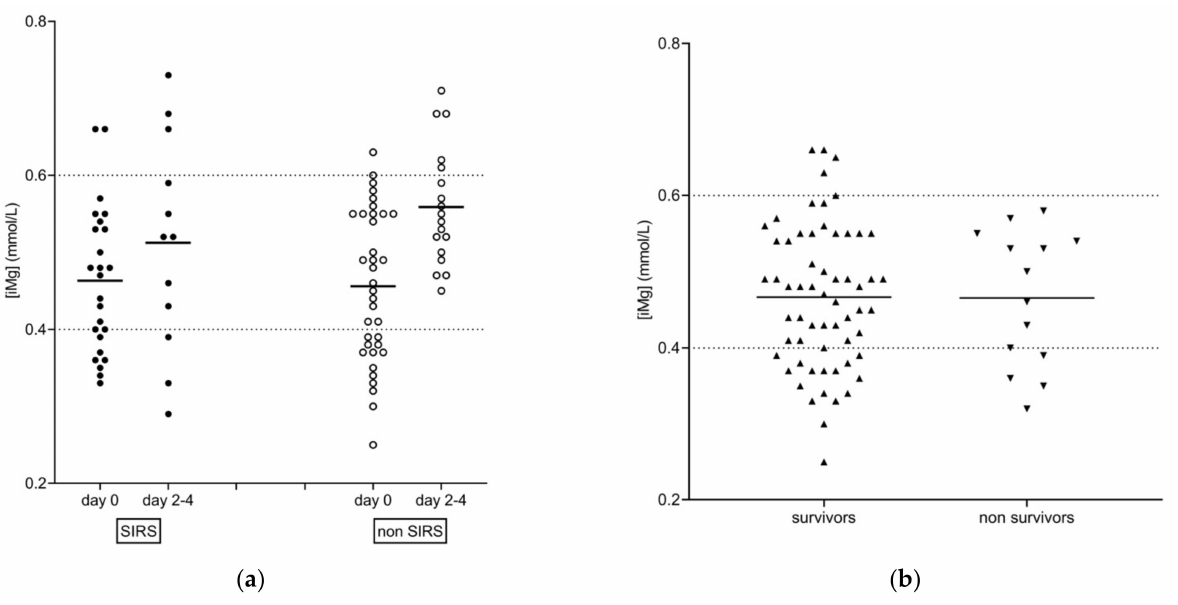
Figure 2. Scatter dot plot of (iMg) (mmol/L) in sick adult horses: ( a ) distributed in columns based on SIRS (solid circles) and non-SIRS (open circles) over time (day 0, day 2–4) and ( b ) distributed in columns based on survivors (solid upward triangles) and non-survivors (solid downward triangles). Horizontal solid lines indicate mean (iMg). Horizontal dotted lines from the left Y axis show the reference range for (iMg) in adult